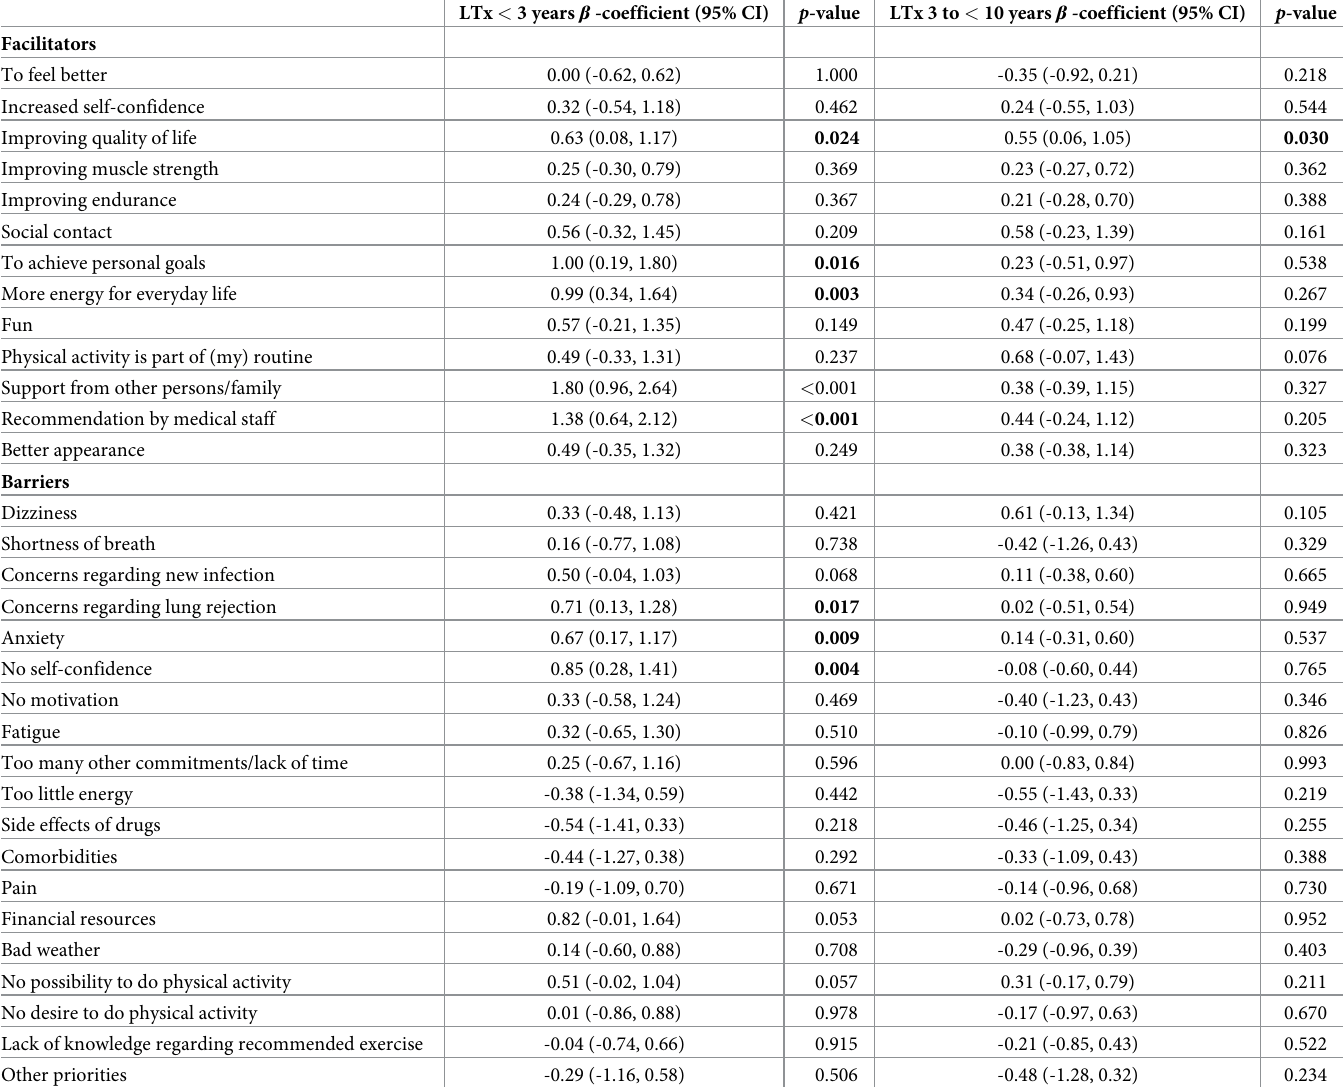
Table 3. Motivations and barriers to physical activity among lung transplant recipients with cystic